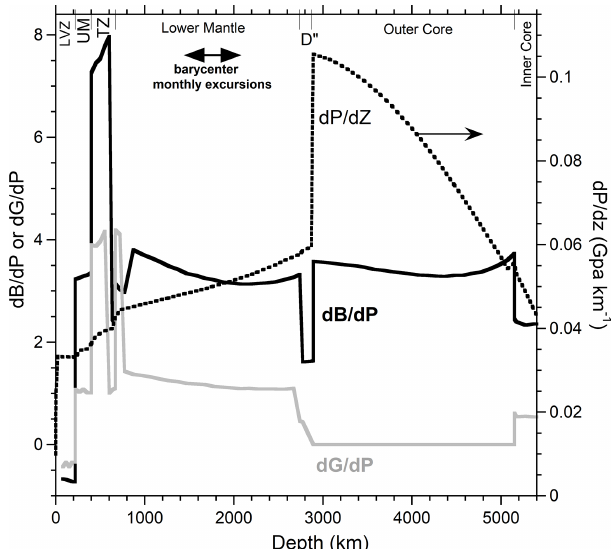
Figure 4. Derivatives from the seismologic model PREM (Dziewonski and Anderson, 1981) as a function of depth. Variables as tabulated by Anderson (2007), from which we calculated the pressure derivatives of the bulk (black) and shear moduli (grey) as well as the depth derivative of pressure